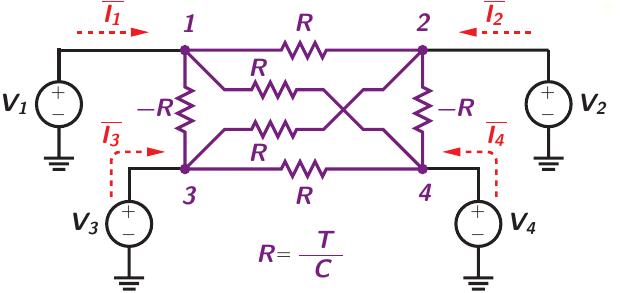
Figure 5. The proposed RN model for single-stage DCP during